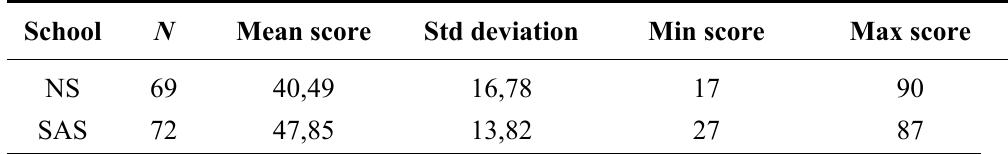
Table 1 : Percentage mean score of all participants in the TPGT